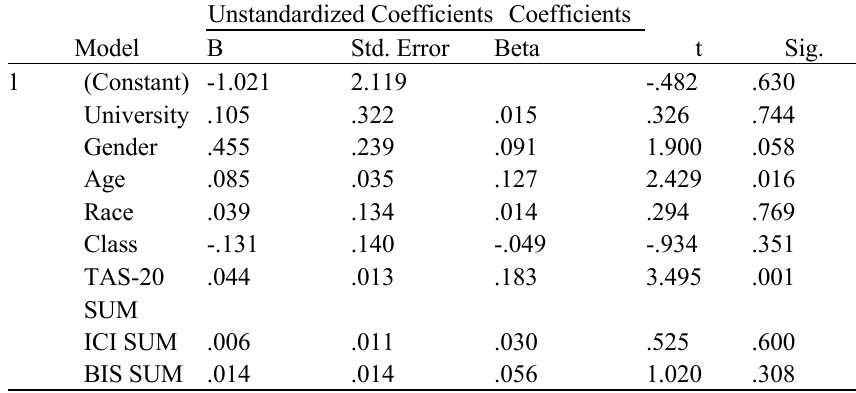
Table 3. Coefficients a of Multiple Regression Analysis with Total Scores of TAS20, BIS, and